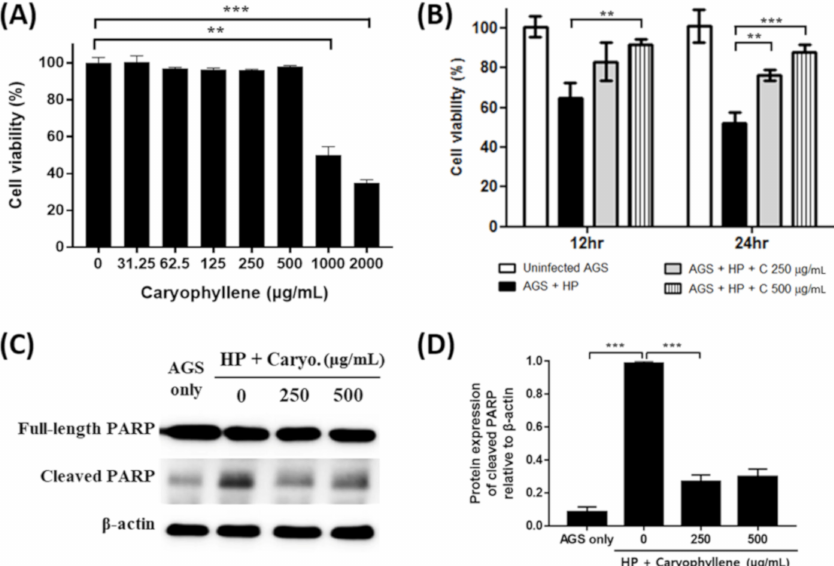
Figure 2. Inhibitory e ff ect of β -caryophyllene on H. pylori -infected AGS gastric cancer cell death. ( A ) AGS cells were treated with the indicated concentrations of β -caryophyllene for 24 h and cell viability was measured by the water soluble tetrazolium salt (WST) assay. Cell viability of AGS cells was decreased with 1000 µ g / mL or higher dose of β -caryophyllene treatment. AGS cells were infected with H. pylori (200 MOI) and treated with β -caryophyllene. ( B ) After 12 or 24 h, cell viability was measured the WST assay. ( C ) The cell lysates were assessed by Western blotting to detect a full-length of poly ADP-ribose polymerase (PARP, 116 kDa) and cleaved PARP (89 kDa). β -actin was used as an internal control. ( D ) The density of the bands are illustrated as a graph. Data in the bar graphs are presented as the mean ± SEM. Data were from the three independent experiments and analyzed by unpaired Student’s t -test (** p < 0.01 and *** p <